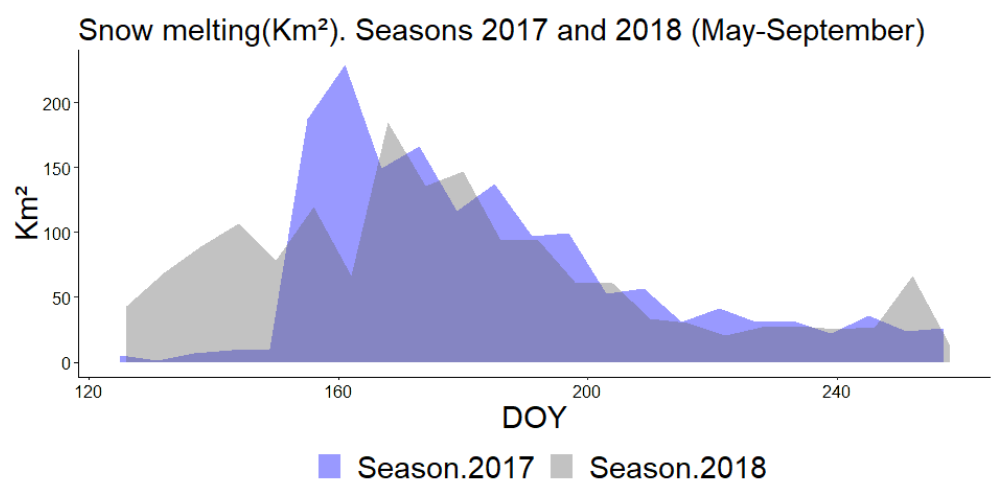
Figure 6. Surface (km 2 ) covered by wet-snow during the melting season 2017 and 2018. The range of days expressed in DOY (from approximately DOY 130, which corresponds to early May, to DOY 250, which corresponds to early September) represents the window in which Sentinel-2 images are usable due to polar night.